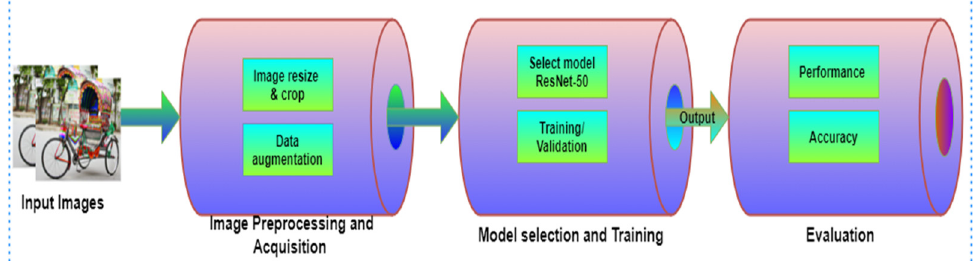
Figure 6. Proposed model approach pipeline.